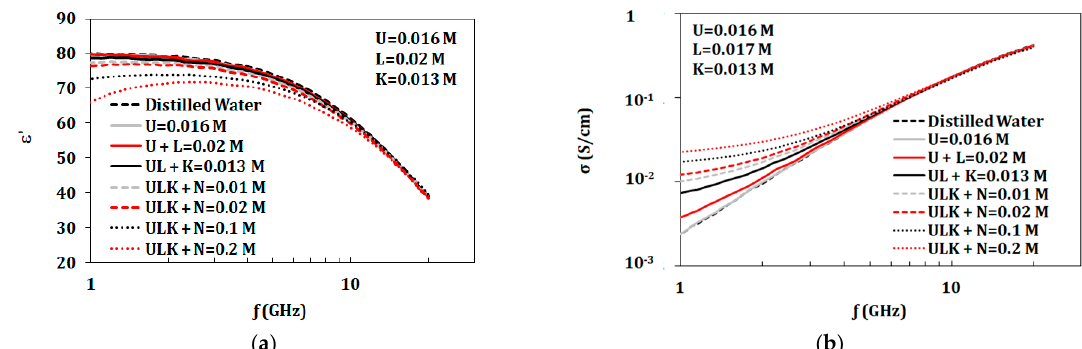
Figure 8. Measured dielectric properties for NaCl solutions at ion concentrations from 0.01 to 0.2 mol/L with a base of 0.013 mol/L KCl, 0.016 mol/L urea, and 0.02 mol/L lactic acid at temperature 23 °C in the range of 1–20 GHz: ( a ) dielectric constant and ( b ) conductivity(“M” refers to mol/L).